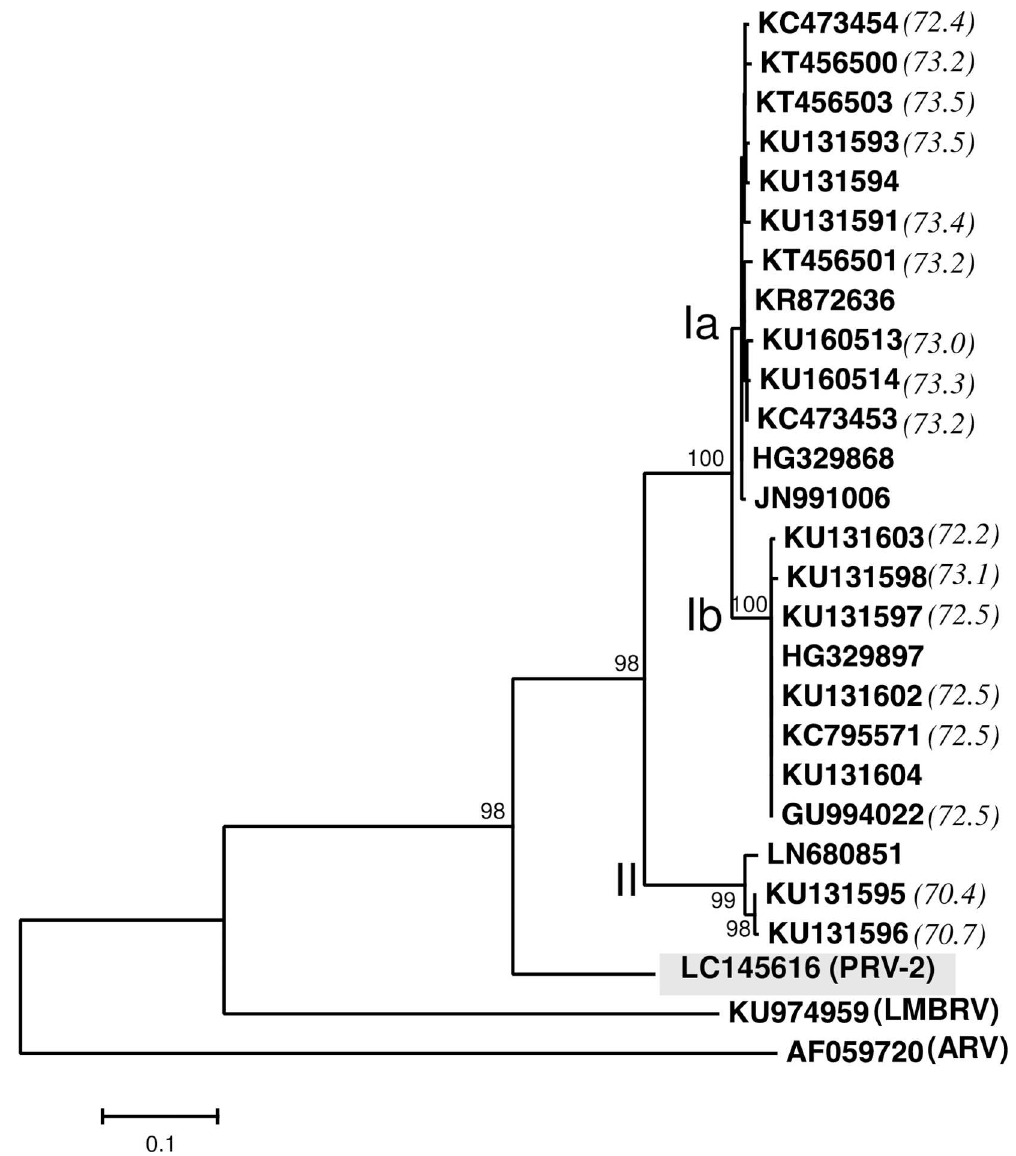
Fig 2. Phylogenetic analysis of segment S1 sequences from the novel virus, PRV genotype I and genotype II isolates, and LMBRV. Phylogenetic tree was constructed with the nucleotide sequencesof segment S1 from the novel virus (LC145616),PRV isolates (subgenotype Ia, subgenotype Ib, and genotype II) and LMBRV (KU974959). The novel virus (PRV-2) is indicatedby a shaded box. An outgroup (ARV: AF059720) was used to determine the root. The tree was constructed with the neighbor-joining method. Numbers on the nodes represent the confidence limits ( > 70%) estimated from 1,000 bootstrap replicates. Percentageidentitiesbetween the novel virus (LC145616)and the complete nucleotidesequence of PRV segment S1 (1,081 bp) are indicatedin